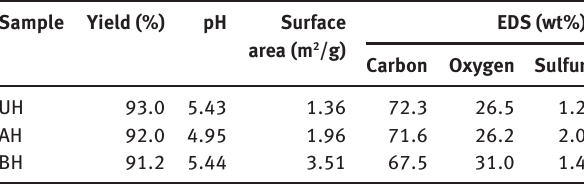
Table 1: Characteristics of human hair